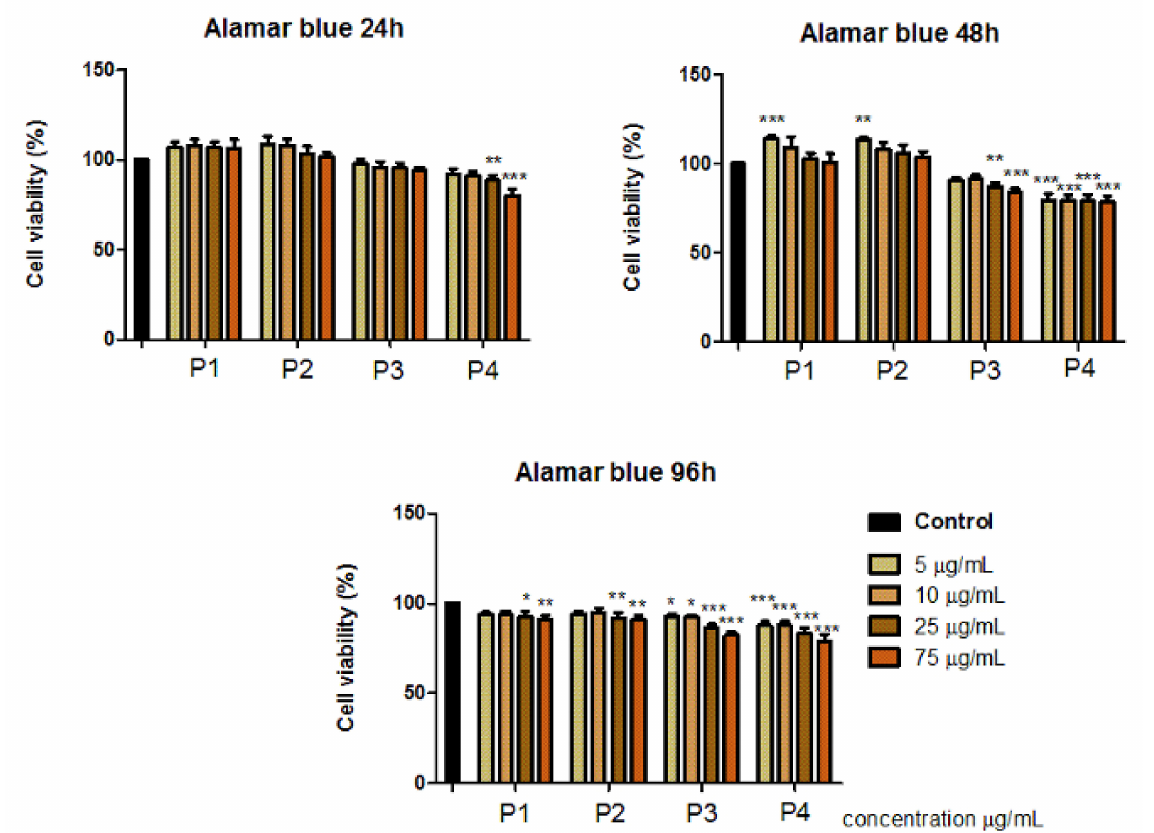
Figure 4. Primary Human Gingival Fibroblast (HGF) response to dental ceramic specimens after 24, 48 and 96 h. The results are presented as cell viability percentage (%) normalized to control cells. The graph bars are expressed as mean values ± SD of three independent experiments. One-way analysis of variance (ANOVA) test was performed to determine the statistical differences of test sample versus control, followed by Tukey’s multiple comparisons post-test (* p < 0.05, ** p < 0.01, *** p <